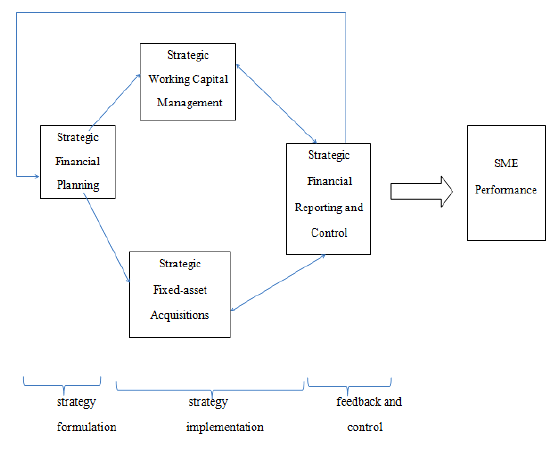
Figure 1: Strategic management model of